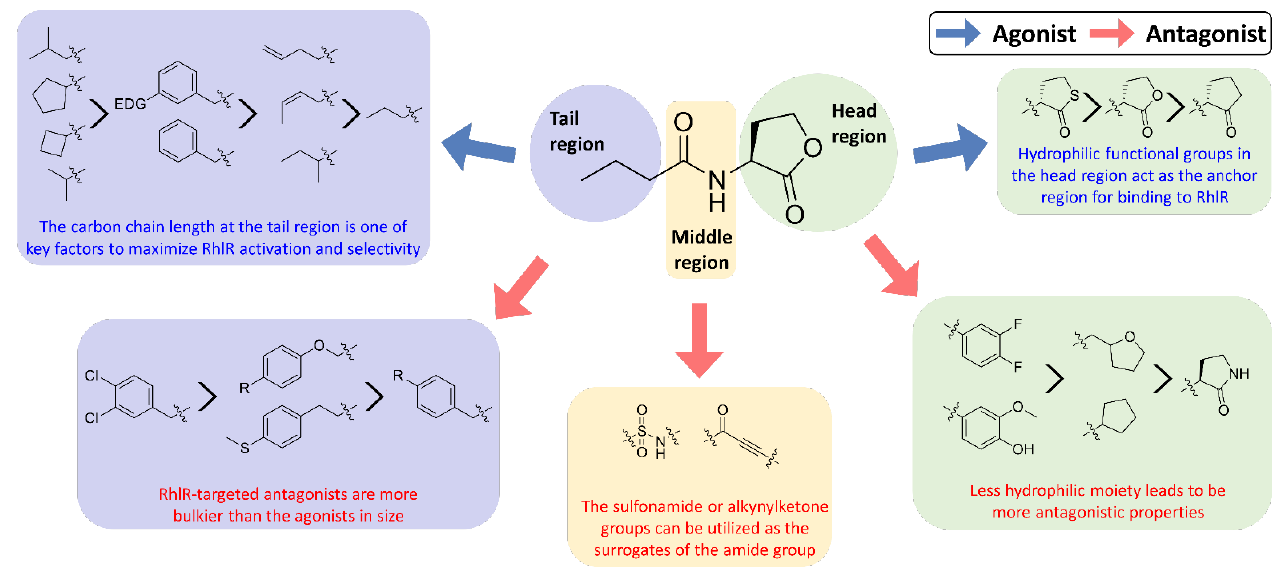
Figure 3. SAR summary of RhlR-targeted agonists and antagonists. P . aeruginosa is a leading cause of airway infections in patients with cystic fibrosis (CF). In isolates from CF patients with chronic P . aeruginosa infections, LasR mutations are